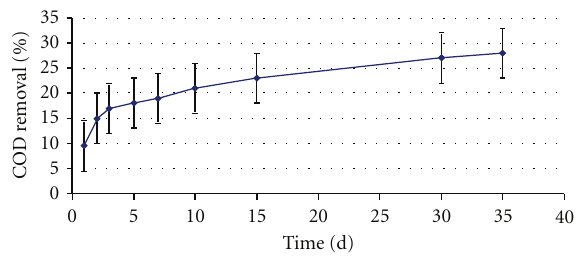
Figure 3: COD removal using reed